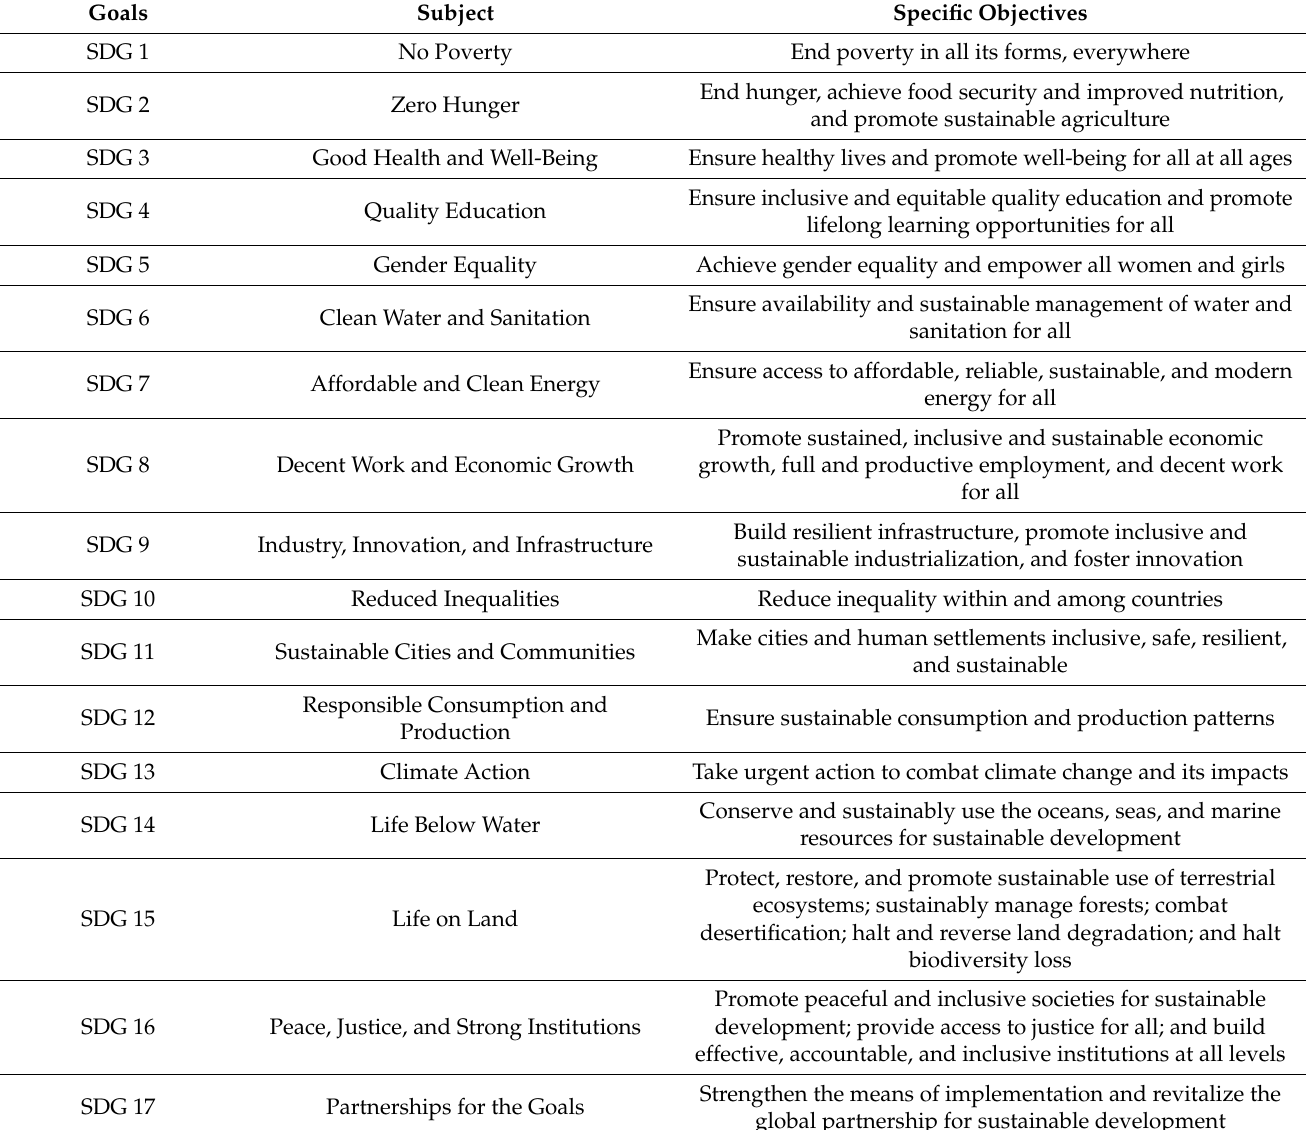
Table 1. Sustainable development